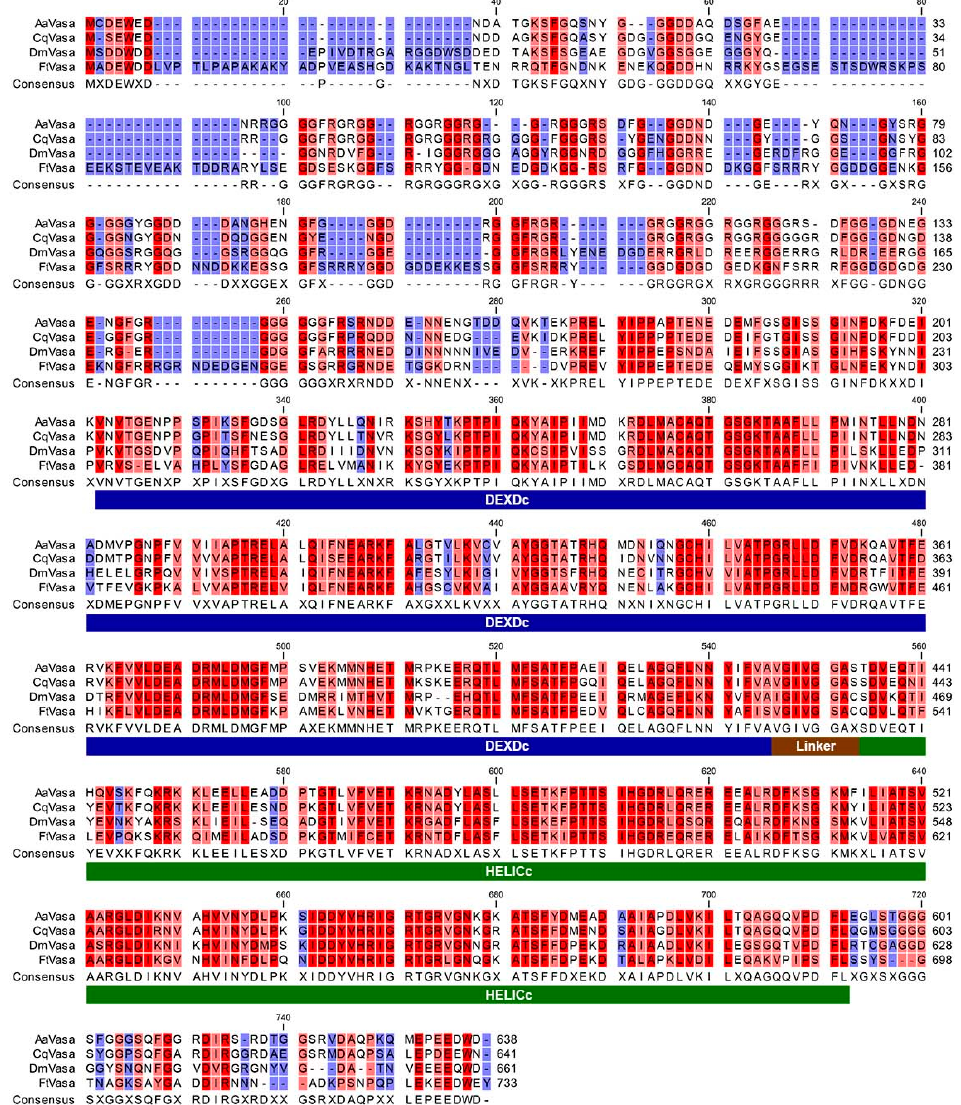
Figure 7. Sequence alignment of Vasa orthologs from F. taiwana and selected species. Multiple sequence alignment of Vasa orthologs from the biting midge Forcipomyia taiwana (FtVasa), fruit fly Drosophila melanogaster (DmVasa), southern house mosquito Culex quinquefasciatus (CqVasa), and yellow fever mosquito Aedes aegypti (AaVasa). The N-terminal region of FtVasa is less conserved. The C-terminal RNA helicase core domain, composed by DEXDc (blue bar) and HELICc (green bar), is highly conserved (see the main text for details). The gradient of the color reflects the level of sequence conservation in the alignment. Red: identical residues; pink: conserved residues; blue: residues with similar properties; white: not conserved residues.